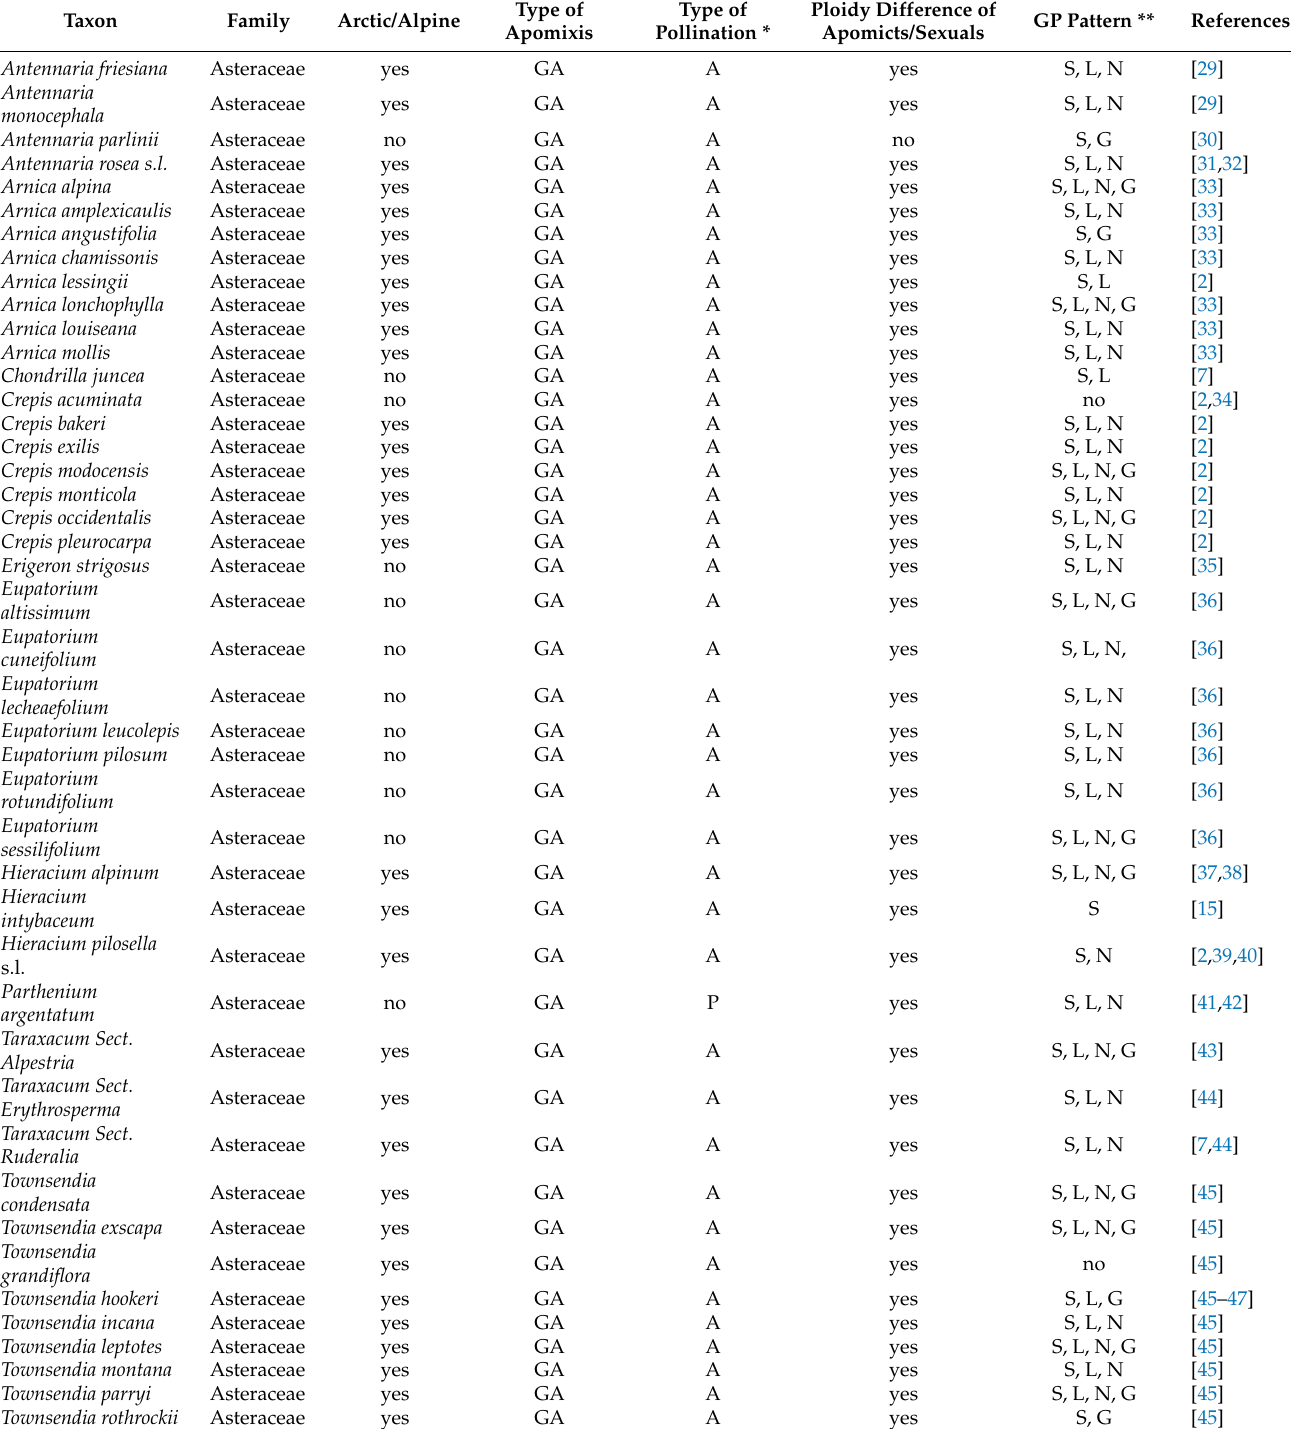
Table 1. Overview of published studies on GP in plants. Arctic/alpine means position of the whole taxon or group; GA = gametophytic apomixis, SA = sporophytic apomixis; A = autonomous apomixis (pollen-independent), P = pseudogamous apomixis (pollen-dependent); S = any geographical sepa- ration of sexuals/apomicts; L = apomicts have larger distribution areas than sexuals; N = apomicts have a more polar distribution than sexuals (towards poles in the northern or southern hemisphere, respectively); G = only apomicts occur in previously glaciated areas, sexuals not. Associations be- tween the main factors (Table 1) were calculated using Past vs. 4.03 [28] (see presence/absence matrix and details in Supplementary Table